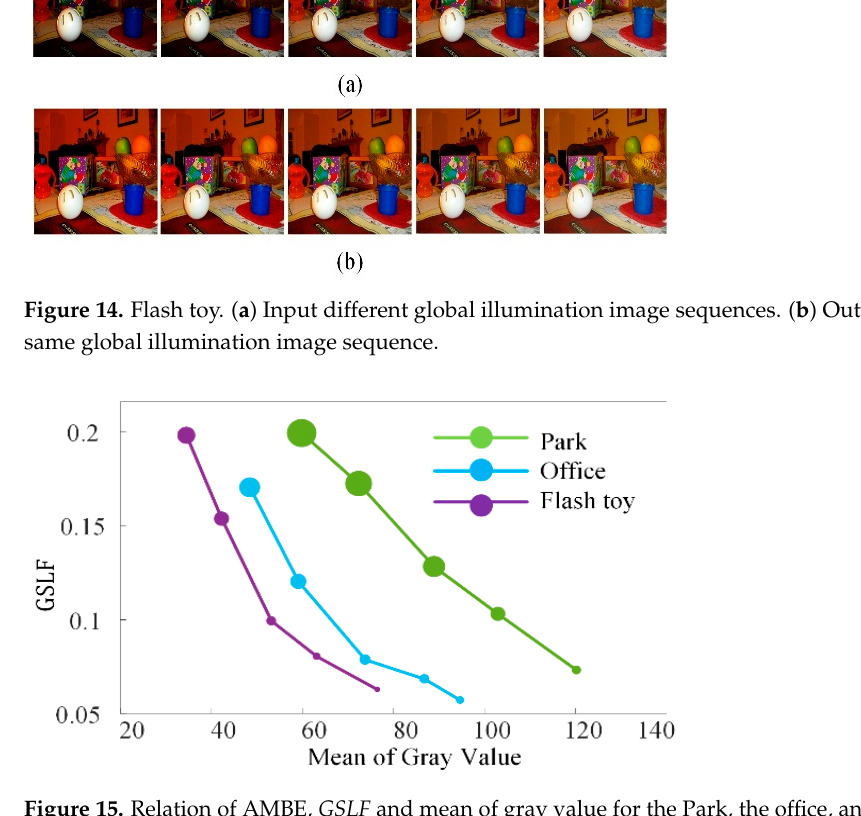
Figure 15. Relation of AMBE, GSLF and mean of gray value for the Park, the office, and the flash toy.